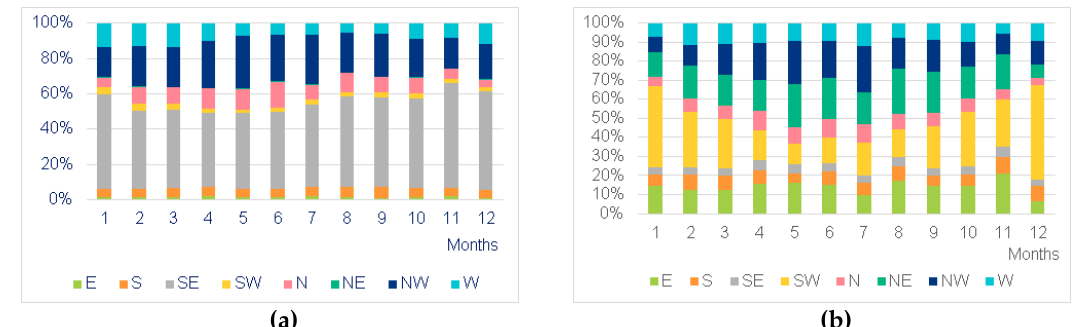
Figure 14. Relative frequency of counts of wind direction representation, 2016–2019: ( a ) the T ř inec-Kosmos site; ( b ) the V ěřň ovice site.